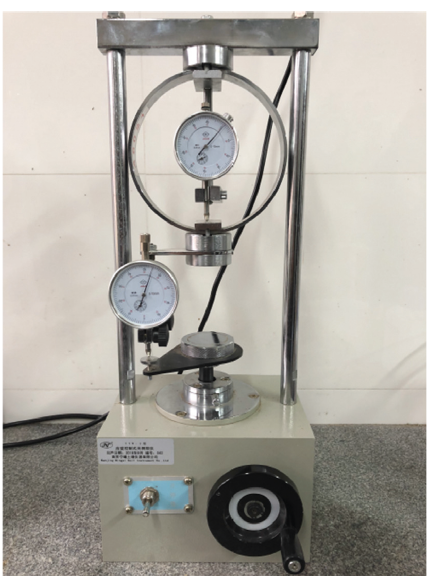
Figure 6: The compression apparatus for unconfined compression tests.